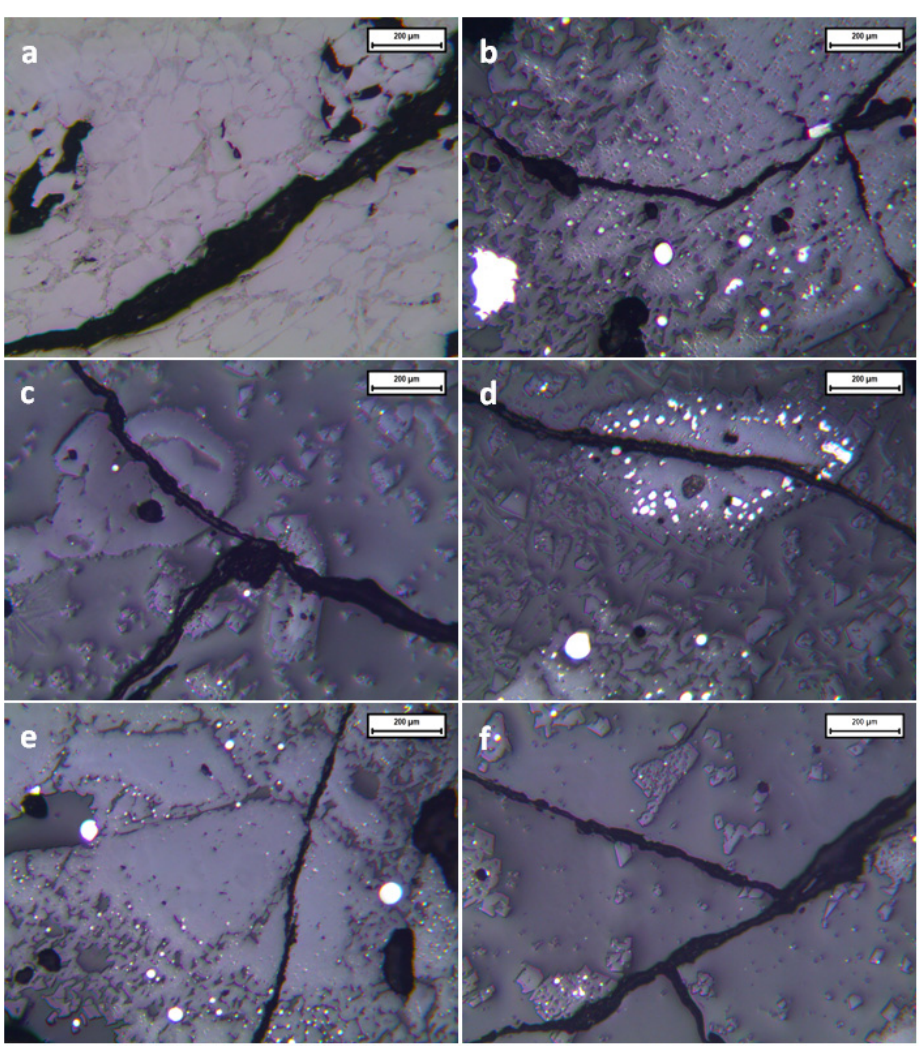
Figure 3. Micrographs of the grounded products after HPGR (coarser sized fractions of +5 and +3 mm).